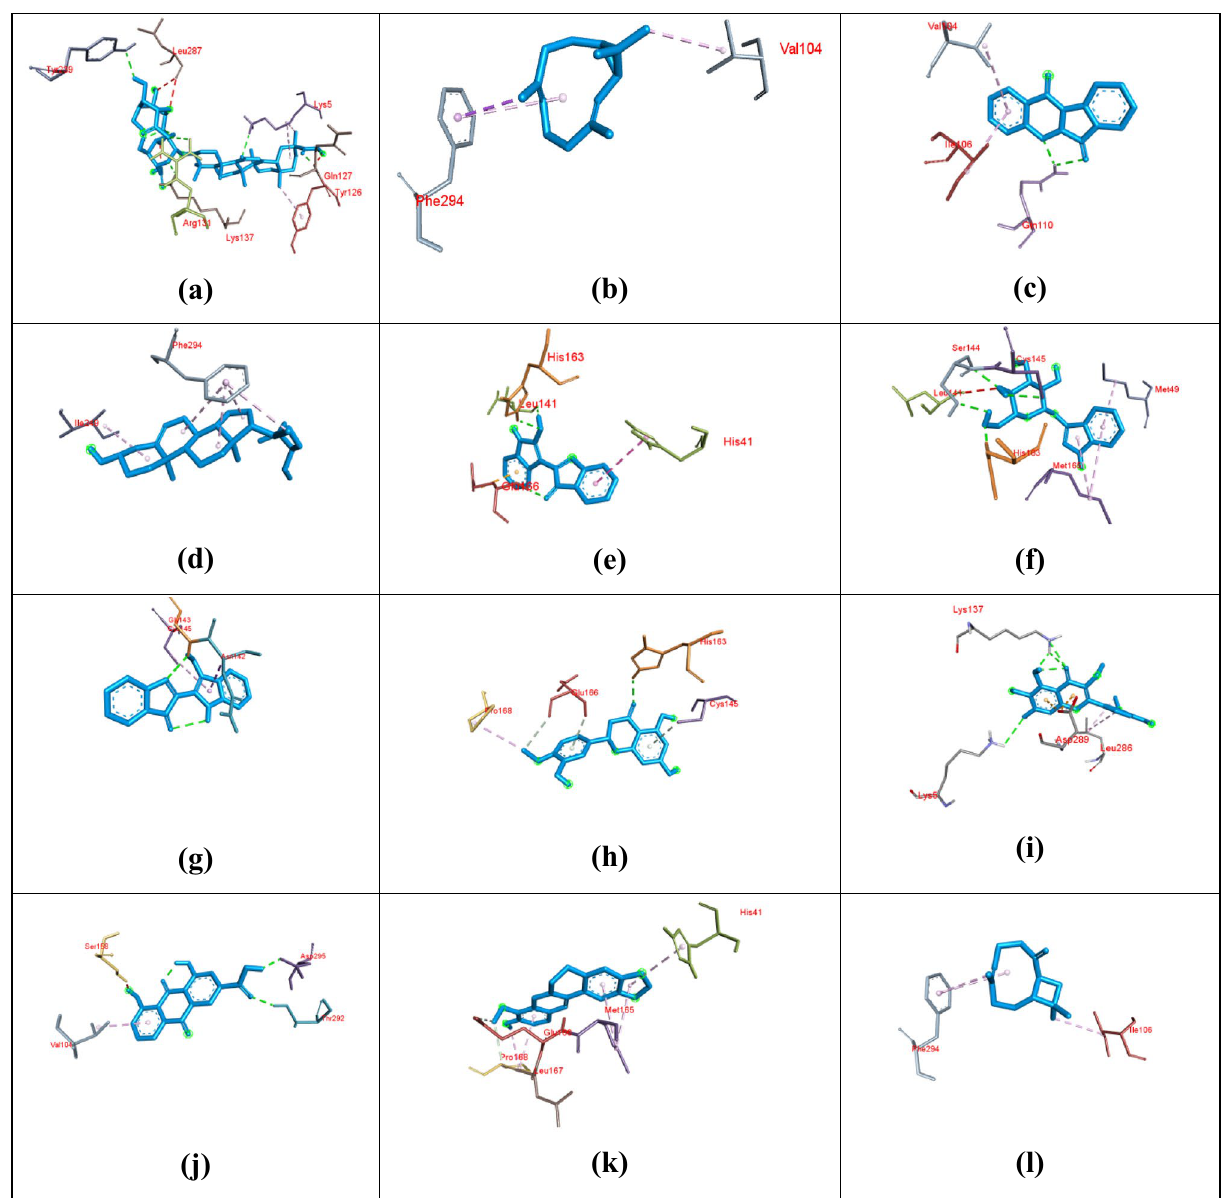
Fig. 2 Visualization of docking results: amino acid residues involved in interaction of a glycyrrhizin, b bicylogermecrene, c tryptanthrine, d β-sitosterol, e indirubin, f indican, g indigo, h hesperetin, i crys-